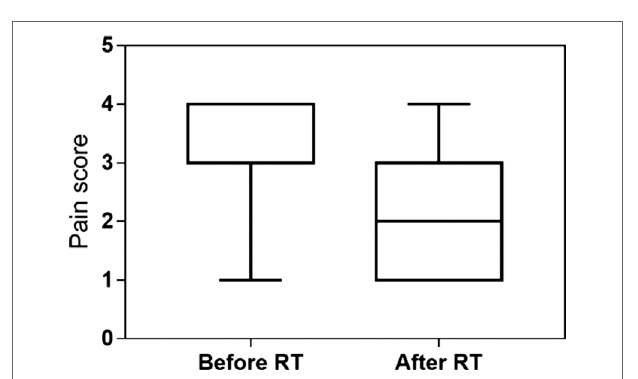
FigUre 4 | Chronic pain index score obtained from the owner’s questioners before and after RT. The median value changed from 32 (95% CI: 29–33) to 20 (95% CI: 16–20), with a significant decrease after the treatment ( P < 0.001).